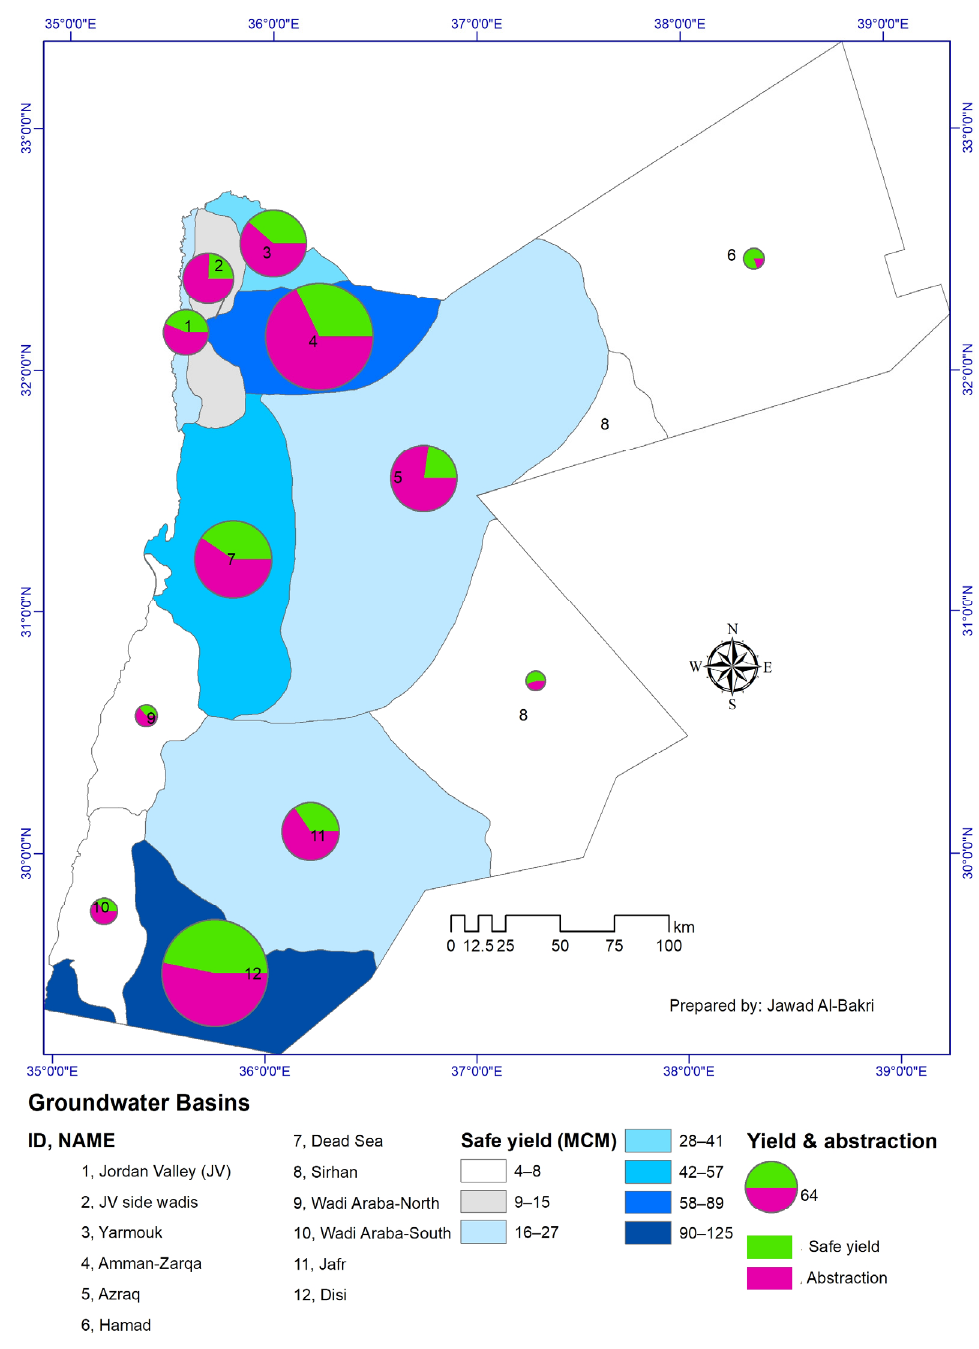
Figure 14. Groundwater basins in Jordan with levels of abstraction and safe